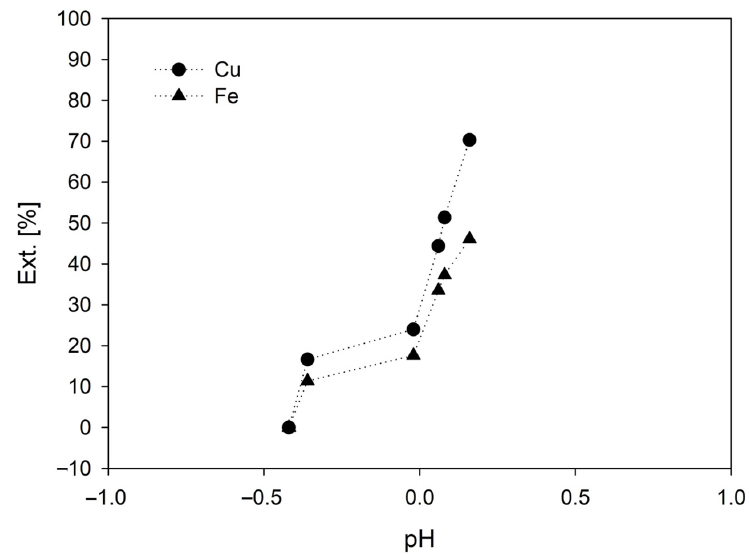
Figure 8. Effect of pH on metal extraction [Conditions: H 2 SO 4 = 0.5 M, 45 °C, 50 g of sample in 1000 mL of seawater solution, 450 rpm].